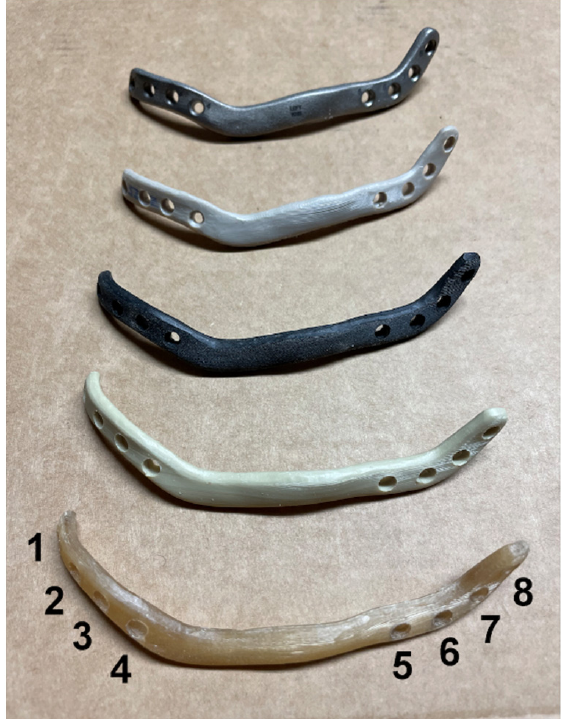
Figure 1. Display of the five different plates used for defect bridging. All plates in this trial are iden- tical in design and dimensions. From top: titanium, polyetheretherketone (PEEK), fiber-reinforced polyetheretherketone (f-PEEK), polyetherketoneketone (PEKK), and polyphenylsulfone (PPSU). The numbers 1–8 symbolize the different drilling holes for implant orientation and selection of the required screw length. Table 1. List of all screw types, positions and respective lengths. Screw Type Position Screw Length